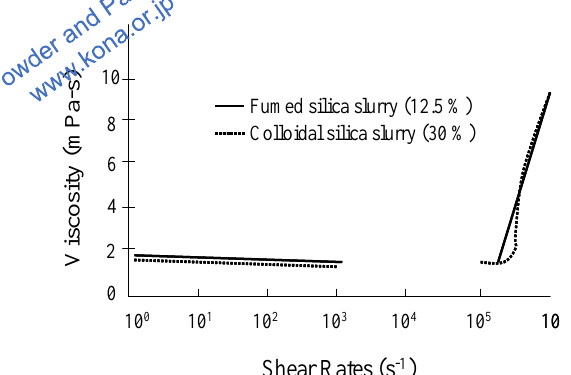
Fig.6 Rhelogical behavior of commercial fumed and colloidal silica slur- ries at different shear rates (Redrawn from Fig.3 in [16)] with per- mission from Material Research Society).